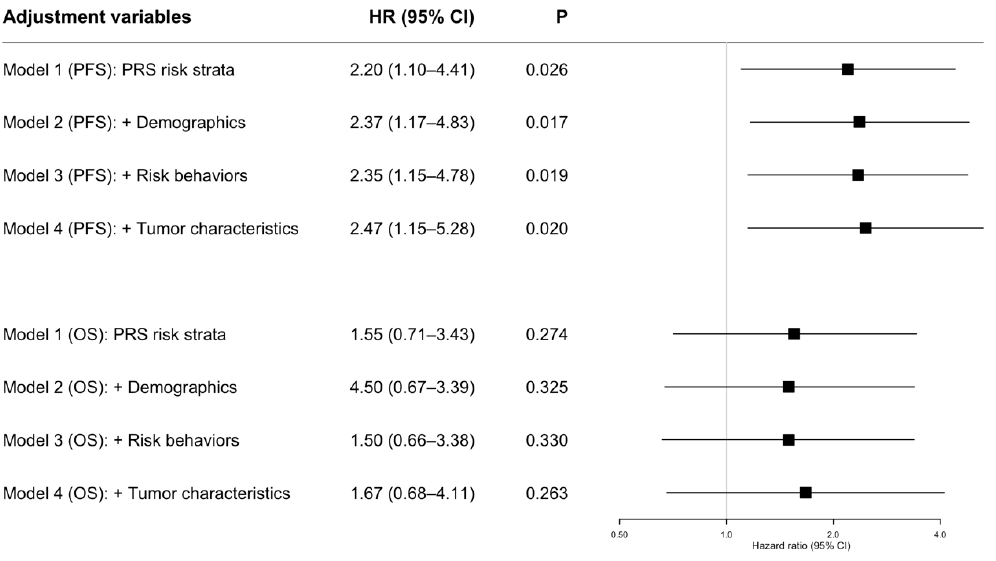
Figure 5. Estimation of the impact of progression risk score (PRS) strata on progression-free survival (PFS) and overall survival (OS) in oral cancer patients using Cox proportional hazard regression models.